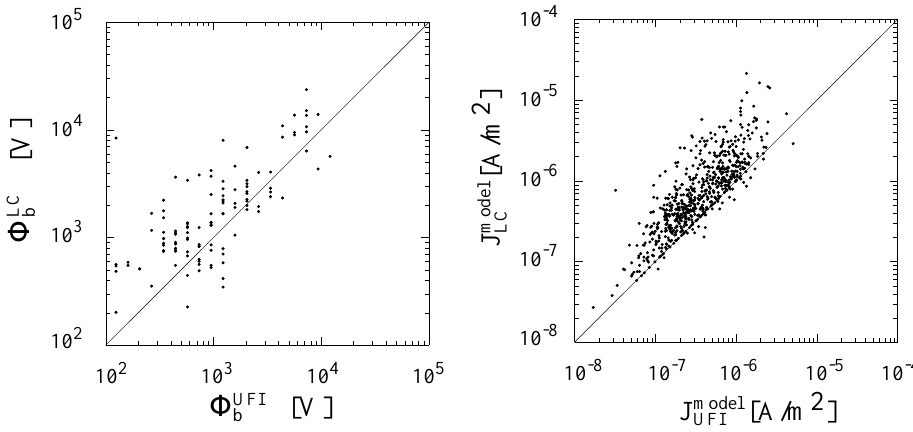
Fig. 6. Left: Comparison of φ b estimated from two different techniques. Right: Comparison of J model